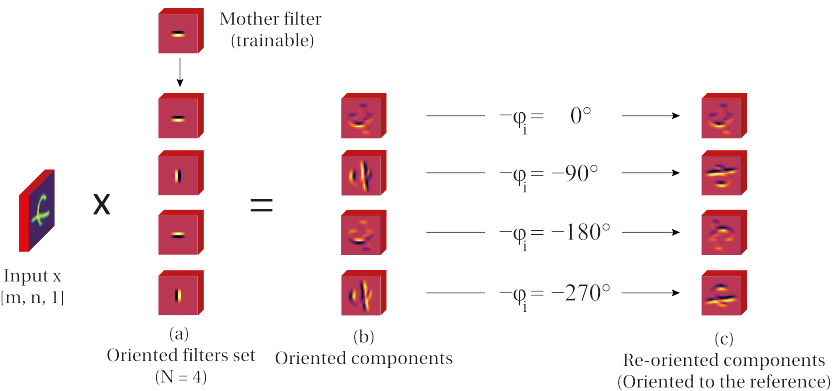
Figure 2. Oriented mapping. First, the image is decomposed by a set of N oriented components. Second, the result is re-oriented to the reference. This becomes a roto-translational feature stage.